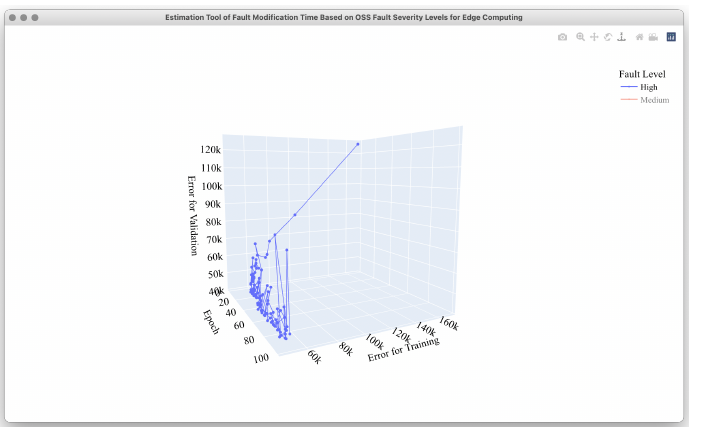
Figure 10. Another angle of the estimated error between validation and training in case of 30% testing data.